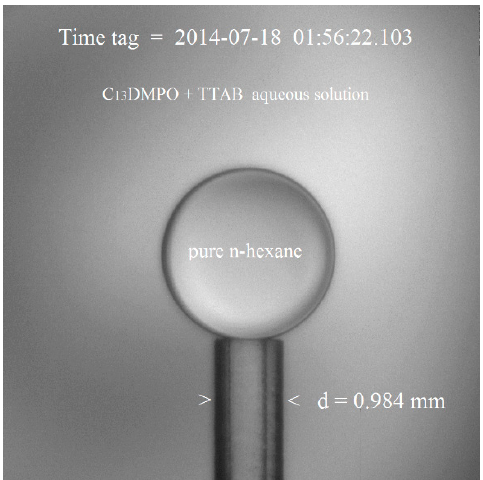
Figure 1. Mixed non-ionic/cationic surfactant components of the aqueous matrix solution (C 13 DMPO + TTAB) and of the adjoining hydrocarbon dispersed phase (pure n-hexane drop).